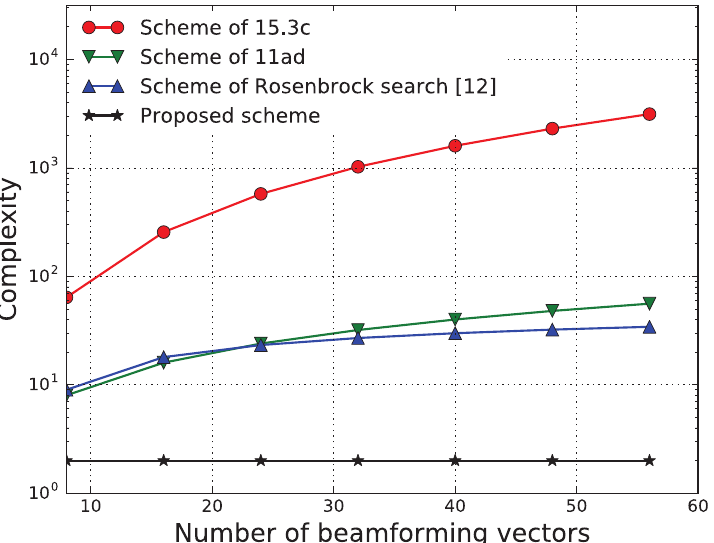
Figure 5. Comparison of beam searching complexity with conventional algorithms vs. number of beamforming